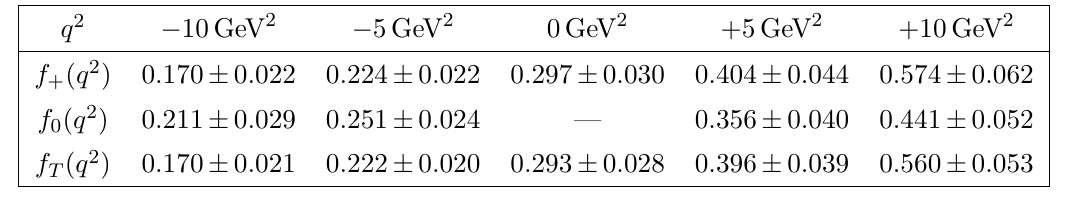
Table 2 . The LCSR predictions for the form factors in five q 2 points. The value of f 0 ( q 2 = 0)